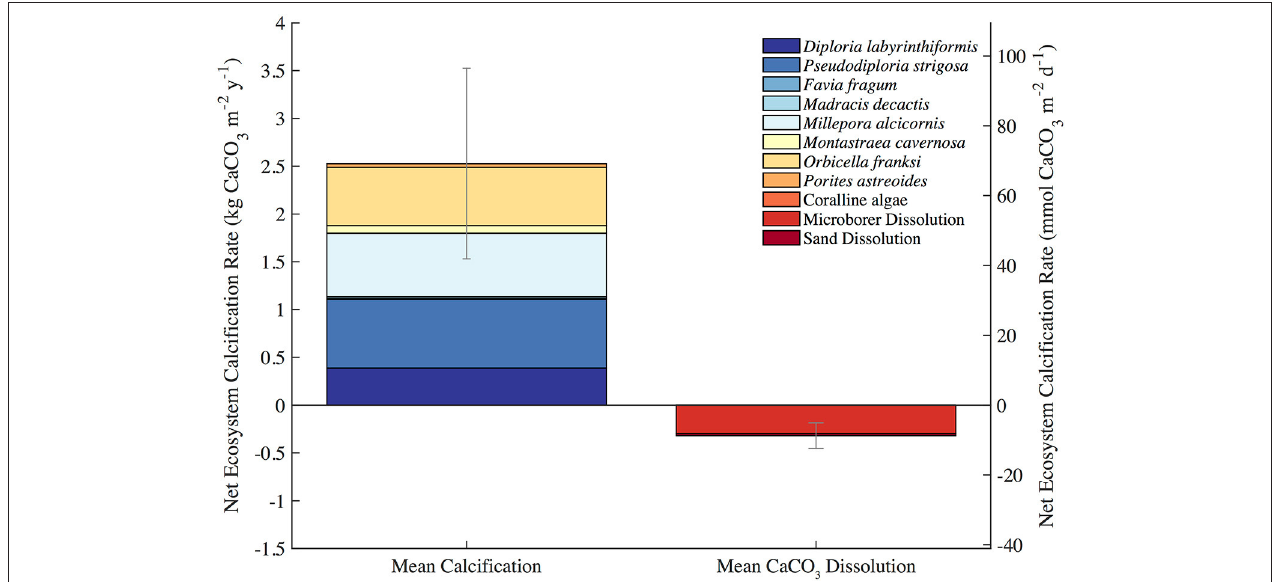
FIGURE 4 | Census-based summary of mean calcification and mean CaCO 3 dissolution. D. labyrinthiformis , P. strigosa , M. alcicornis , and O. franksi are the dominant biocalcifiers and microborer activity dominates CaCO 3 dissolution at Hog Reef.